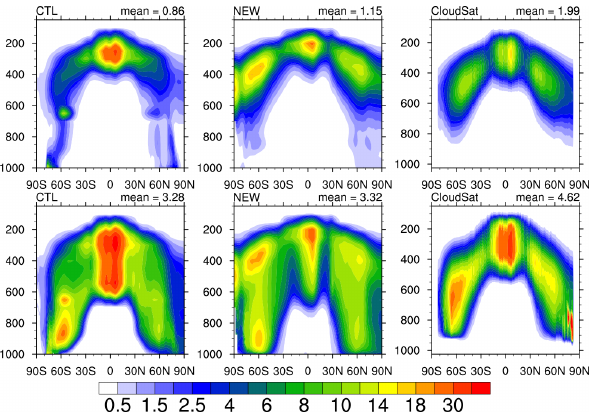
Figure 8. Zonal mean non-convective ice water mass mixing ratio (mgkg − 1 ) (upper panels) and total ice condensate (ice and snow, bottom panels) for non-convective clouds from the CTL and NEW runs and the CloudSat retrieval (Li et al., 2012). Model results span over 10 years of simulation, whereas CloudSat retrievals are plotted for the period 2007 to 2008.